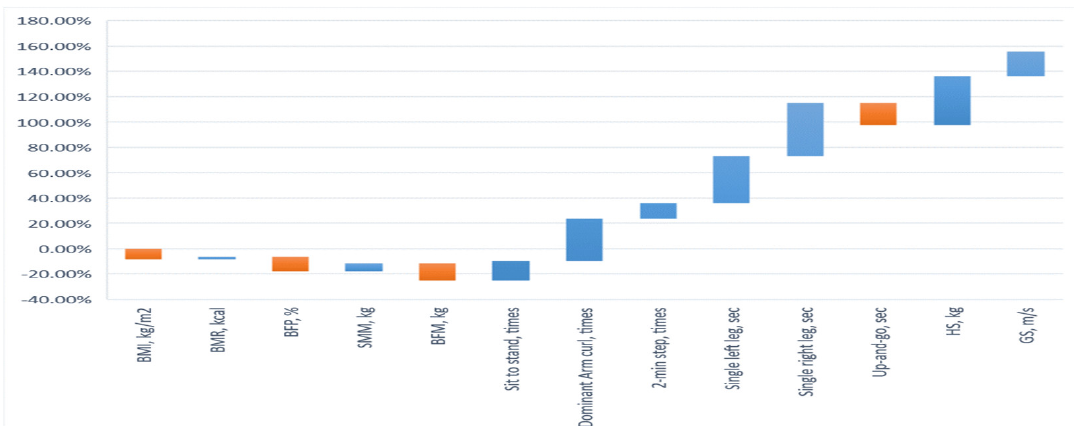
Figure 1. Participant outcomes after intervention with a moderately intensity physical activity pro- gram.